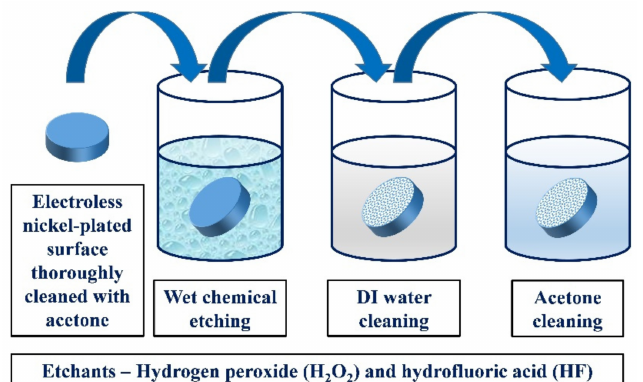
Figure 1. Schematic of wet chemical treatment of electroless nickel-plated surface. The chemicals were selected based on the affinity of the nickel surface. These two chemicals are different in terms of their application to the nickel-plated surface. The details of chemical formulation are listed in Table